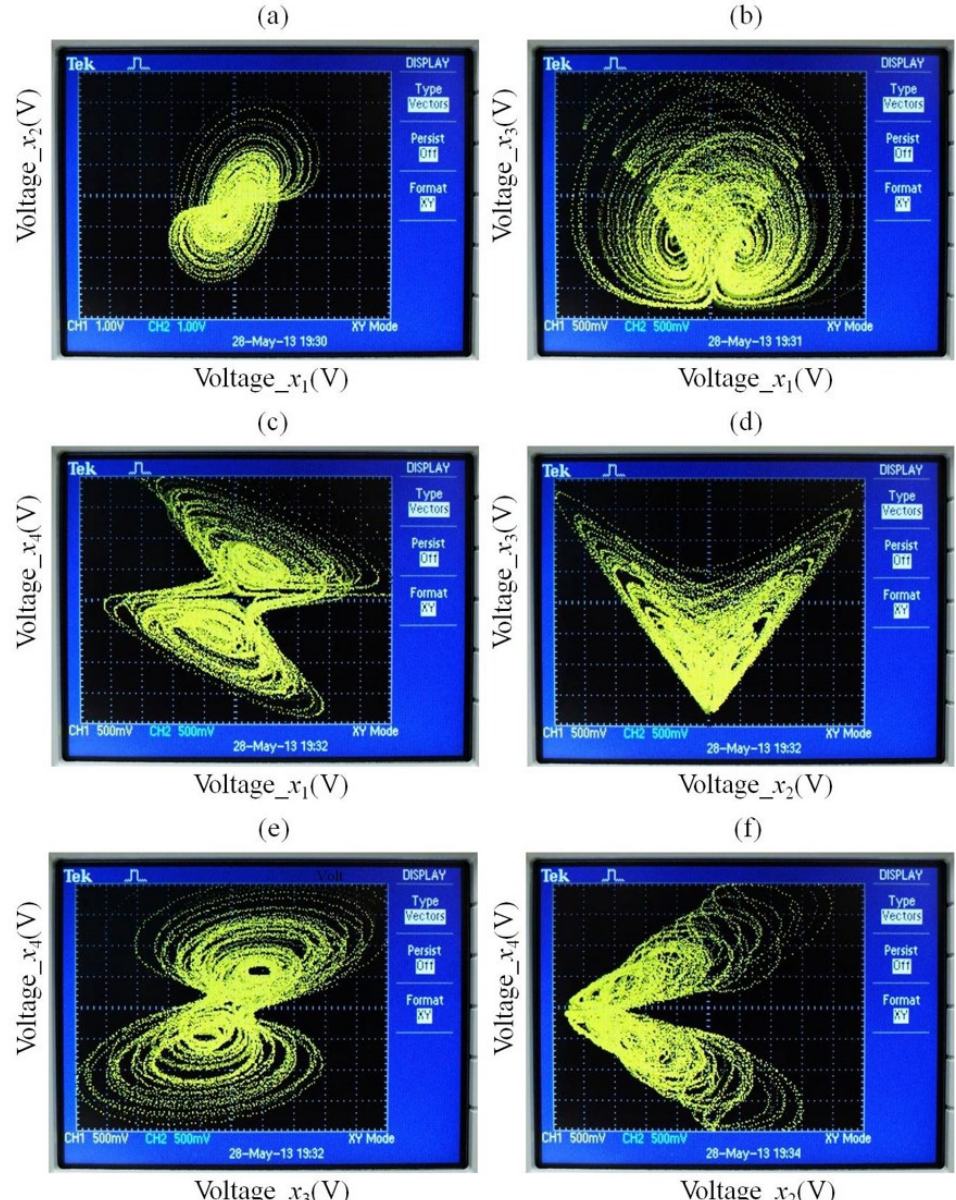
Figure 7. 2-D phase portraits of the four-dimensional Chen–Lee system implemented on real elec- tronic circuits: ( a ) 𝑥 (cid:2869) ,𝑥 (cid:2870) plane; ( b ) 𝑥 (cid:2869) ,𝑥 (cid:2871) plane; ( c ) 𝑥 (cid:2869) ,𝑥 (cid:2872) plane; ( d ) 𝑥 (cid:2870) , 𝑥 (cid:2871) plane; ( e ) 𝑥 (cid:2870) , 𝑥 (cid:2872) tronic circuits: ( a ) x 1 , x 2 plane; ( b ) x 1 , x 3 plane; ( c ) x 1 , x 4 plane; ( d ) x 2 , x 3 plane; ( e ) x 2 , x 4 plane; plane; ( f ) 𝑥 (cid:2871) ,𝑥 (cid:2872) plane. ( f ) x 3 , x 4